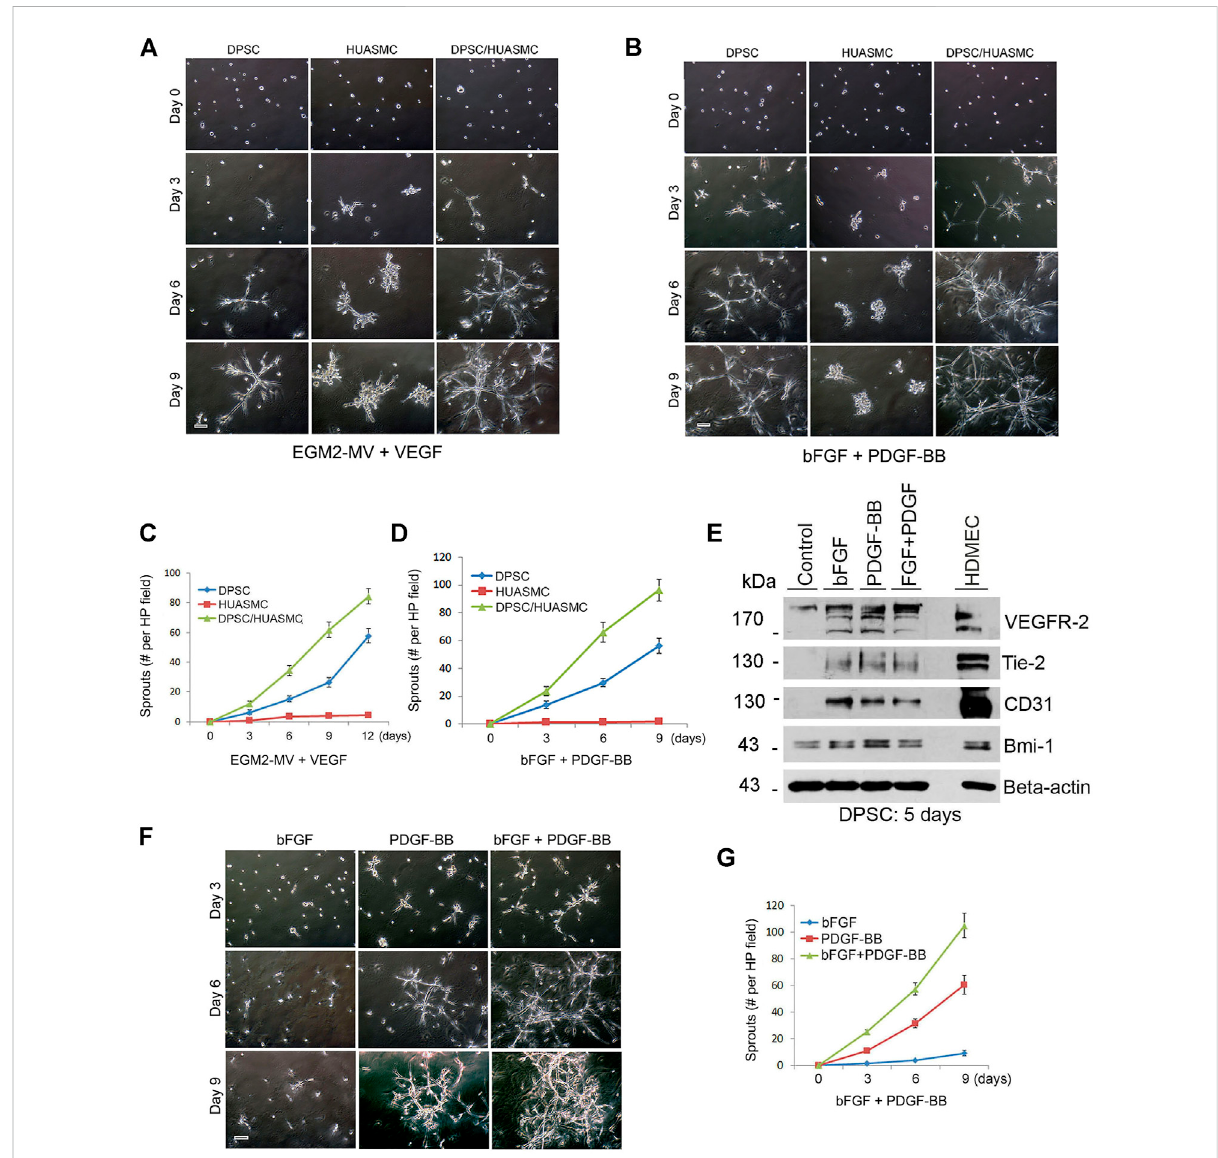
positive controls (A) , or α -MEM supplemented with 5% FBS +20 ng/ml bFGF +20 ng/ml PDGF (B) for indicated time points. Sprouting formation was photographed and the number of sprout-like structures was counted. (C,D) Graphs depicting the numbers of sprouting from (A) and (B) , respectively. Scale bar: 100 µm. (E) DPSC cells were cultured with α -MEM supplemented with 5% FBS in presence of 20 ng/ml bFGF, PDGF-BB or bFGF + PDGF-BB for 5 days. Western blots were performed for VEGFR2, Tie-2, CD31, Bmi-1, and GAPDH (loading control). (F) DPSC were plated